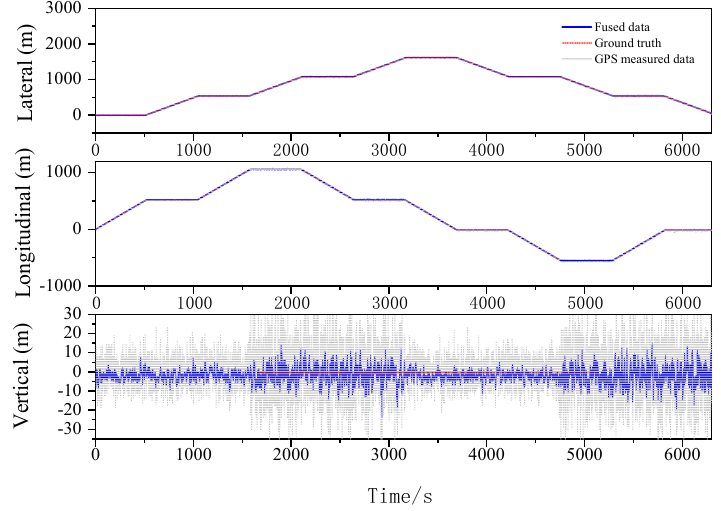
Figure 14. Lateral, Longitudinal and Vertical positions of EKF (Polygonal).